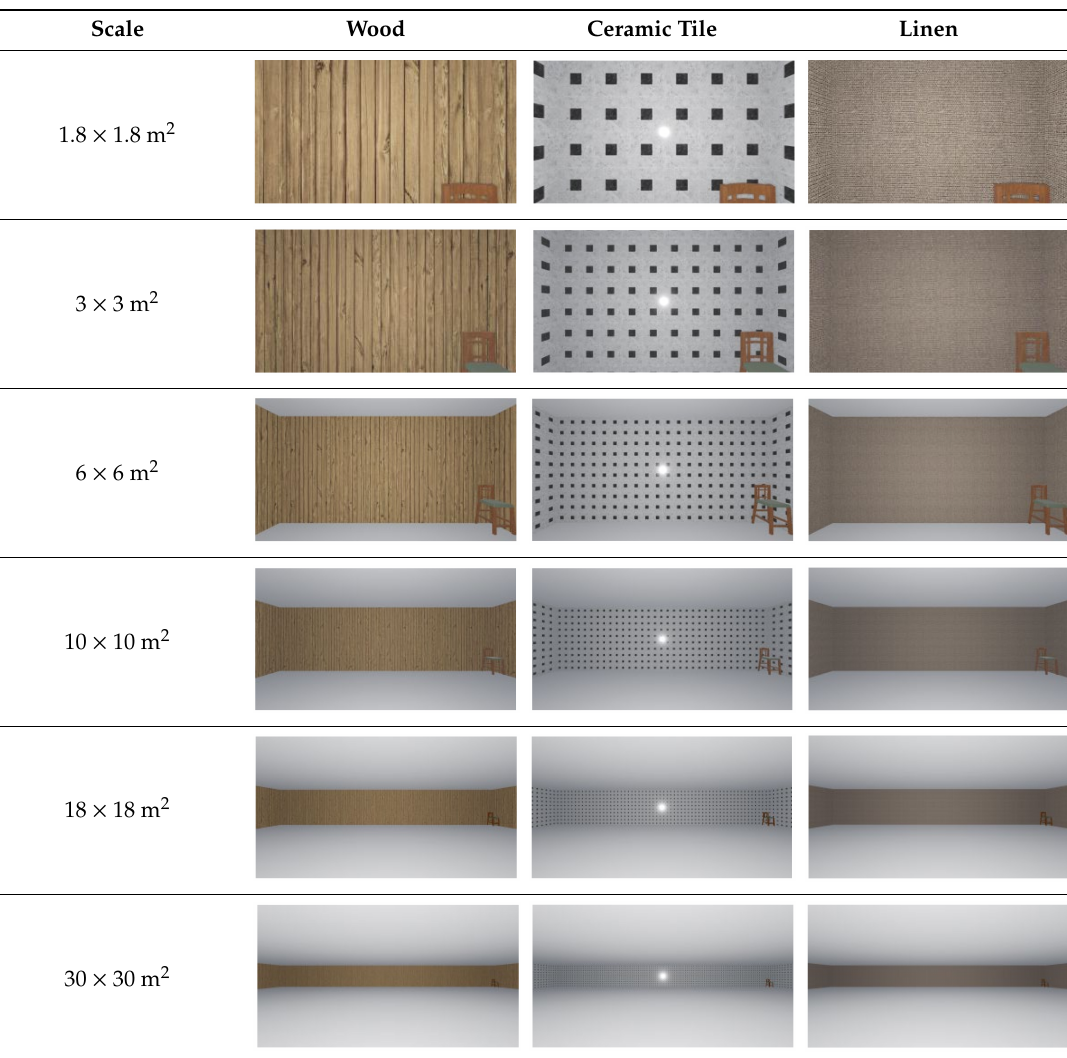
Table 3. Relative stimuli for Experiment